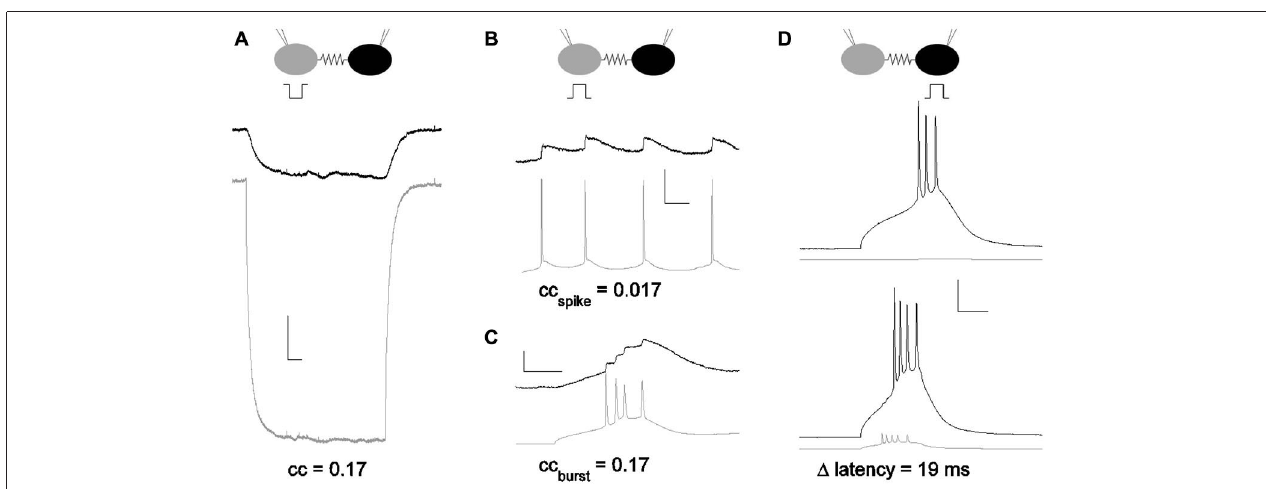
FIGURE 1 | Subthreshold and suprathreshold measurements for the strength of an electrical synapse. (A) Coupling measured with current pulses. Coupling coefficients are a ratio of voltage deflections. Here, voltage deflections were initiated by a step in current delivered in one neuron (gray) that echoed in the coupled neuron (black). cc = 0.17 for the pair shown. Scale bar 1 mV, 50 ms. (B) Coupling coefficient measured by spike and spikelet amplitudes. Spikes were elicited in one neuron (gray) and spikelets in the coupled neighbor (black). Scale bar 2.5 mV (black,) 25 mV (gray), 25 ms. (C) Coupling coefficient measured by burst and burstlet amplitudes, for a longer burst event in one neuron (gray) and a burstlet in the coupled neighbor (black). Scale bar 2.5 mV (black), 25 mV (gray), 25 ms. (D) Coupling measured by latency changes. Modulation of spike latency δ L was measured by comparing timing of spikes elicited in one cell alone (black; gray cell quiet), and with the coupled neighbor also driven to spike (gray). Scale bar 2 mV (gray), 20 mV (black), 25 ms. All data presented are from the same